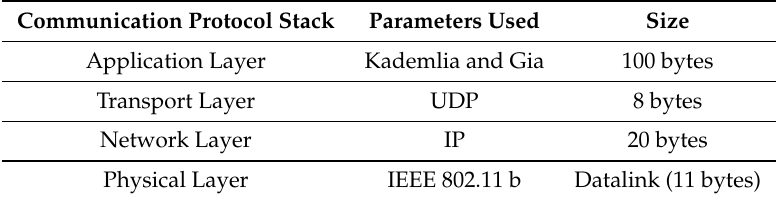
Table 4. Simulation parameters for the communication protocol stack [22]. UDP; user datagram protocol; IP: internet